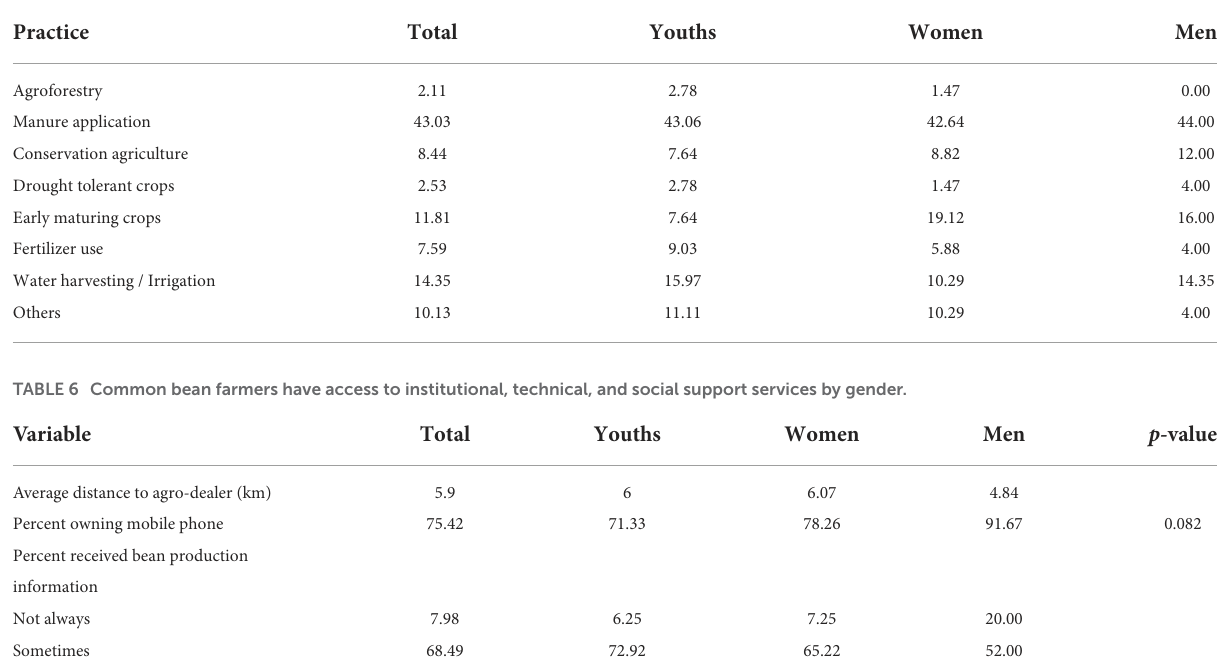
TABLE 5 Use of climate-smart agricultural technologies/practices by gender. Practice Total Agroforestry